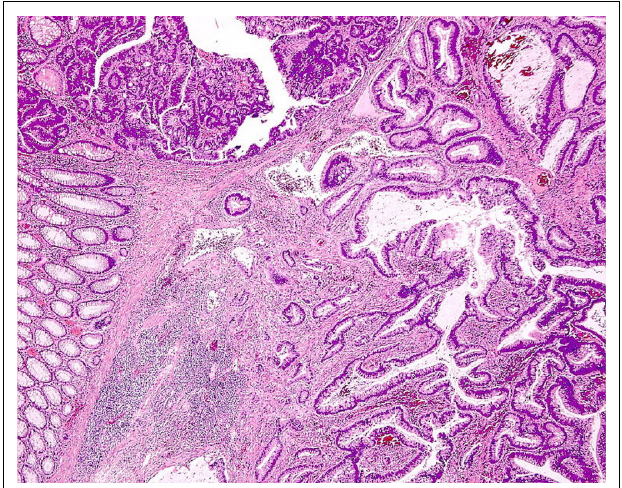
FIGURE 1 | Histologic section of a colonic adenoma containing invasive carcinoma. High grade mucosal neoplasia is strictly confined above the muscularis mucosae, whereas well differentiated adenocarcinoma extensively invades the submucosa (lower right corner).